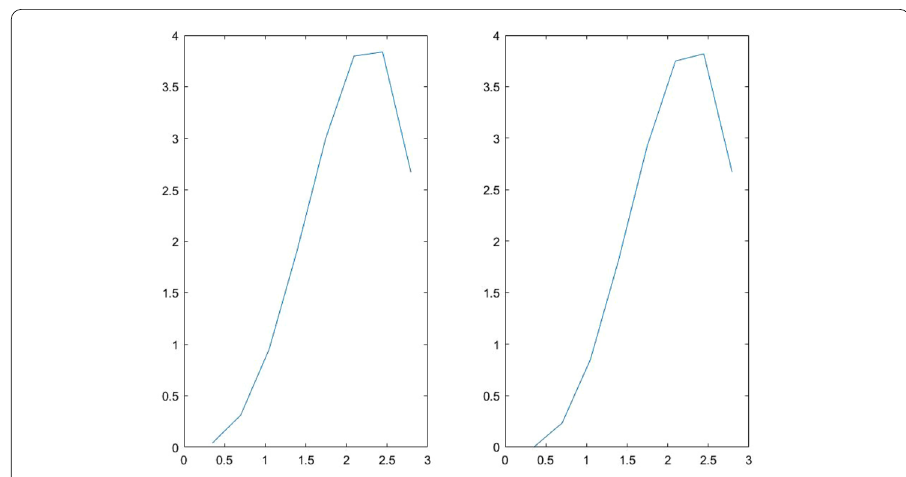
Figure 6 The analytical solution (left) and the numerical solution (right) for Ex.